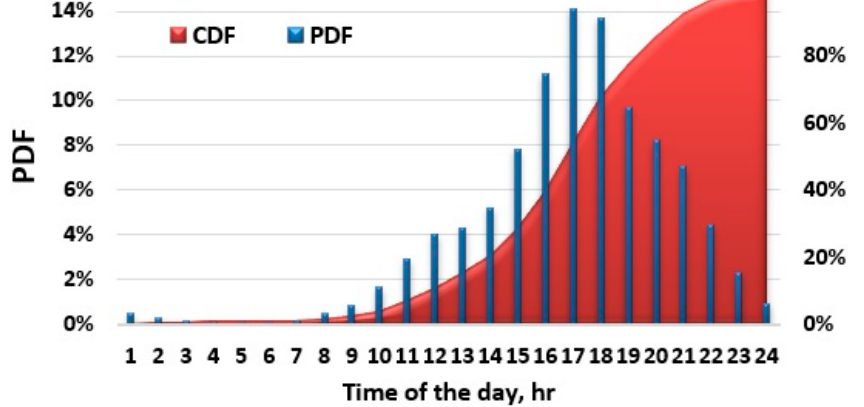
Figure 2. PDF and CDF of arrival time to home.